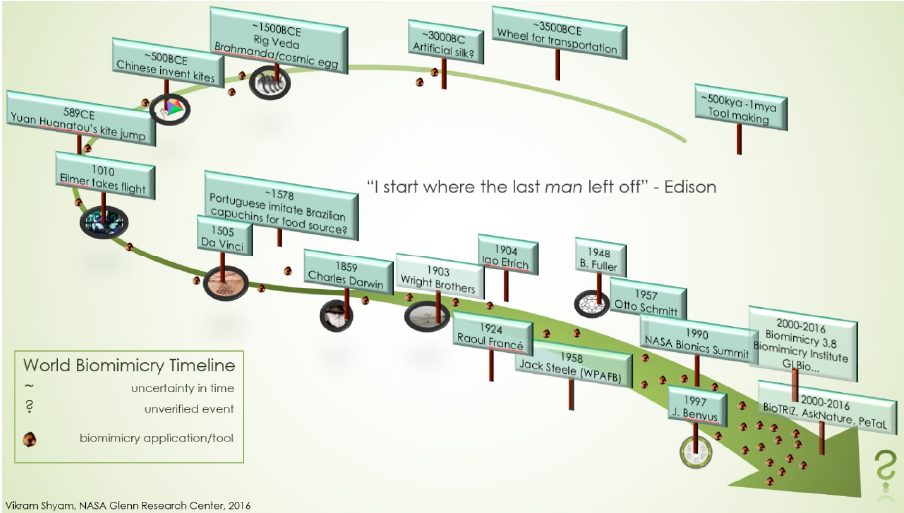
Figure 1. System concept enabled through artificial intelligence (AI)-driven design and analysis.